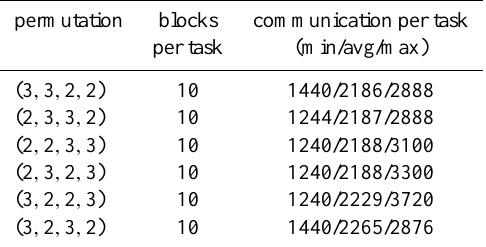
Table 1. Permutations of the [3 , 3 , 2 , 2] example distribution show- ing the number of assigned blocks and the communication per task in grid points per level. The entries are sorted by average communi- cation per task. The topmost entry provides the best